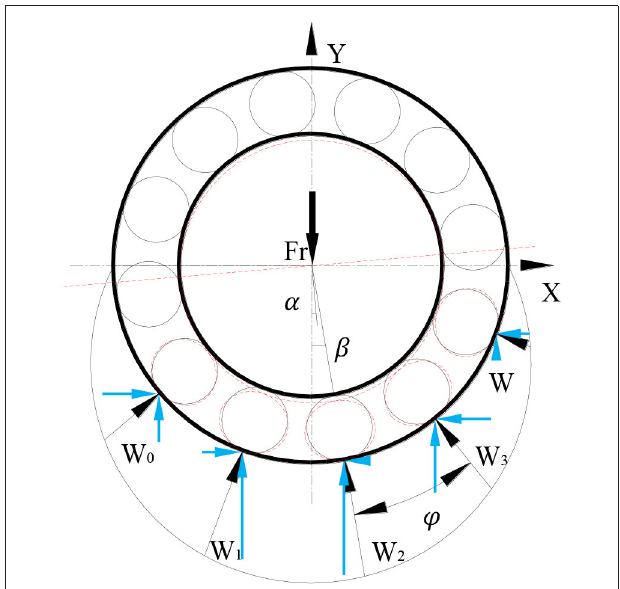
FIGURE 1 | Mechanics analysis of deep groove ball bearing.